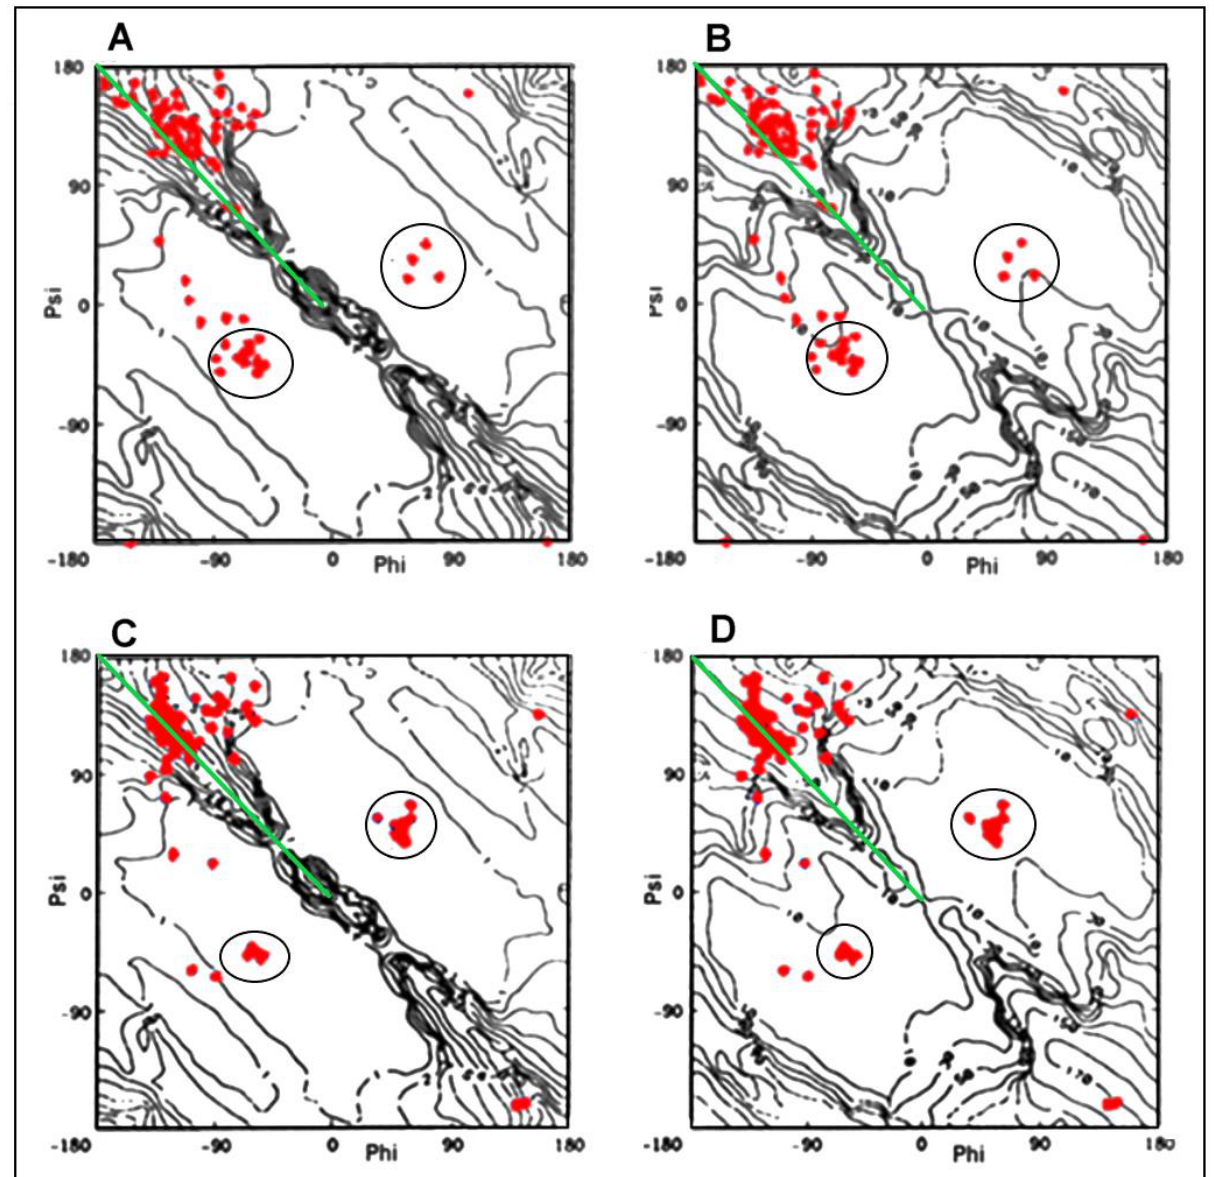
Figure 5. Superposition of pairs of Phi, Psi angles for transthyretin — reference form 1DVQ ( A , B ) and amyloid form — 6SDZ ( C , D ) (red points): ( A , C ) — on radius of curvature map; ( B , D ) — V-angle map. Green line visualizes the position of Psi = − Phi. The approach to this line can be seen in amyloid forms in respect to the distribution observed in WT form of transthyretin. The blue circles visualize the low distribution of angles in right- and left-handed α -helix in amyloid form in respect to analogous WT forms of transthyretin.